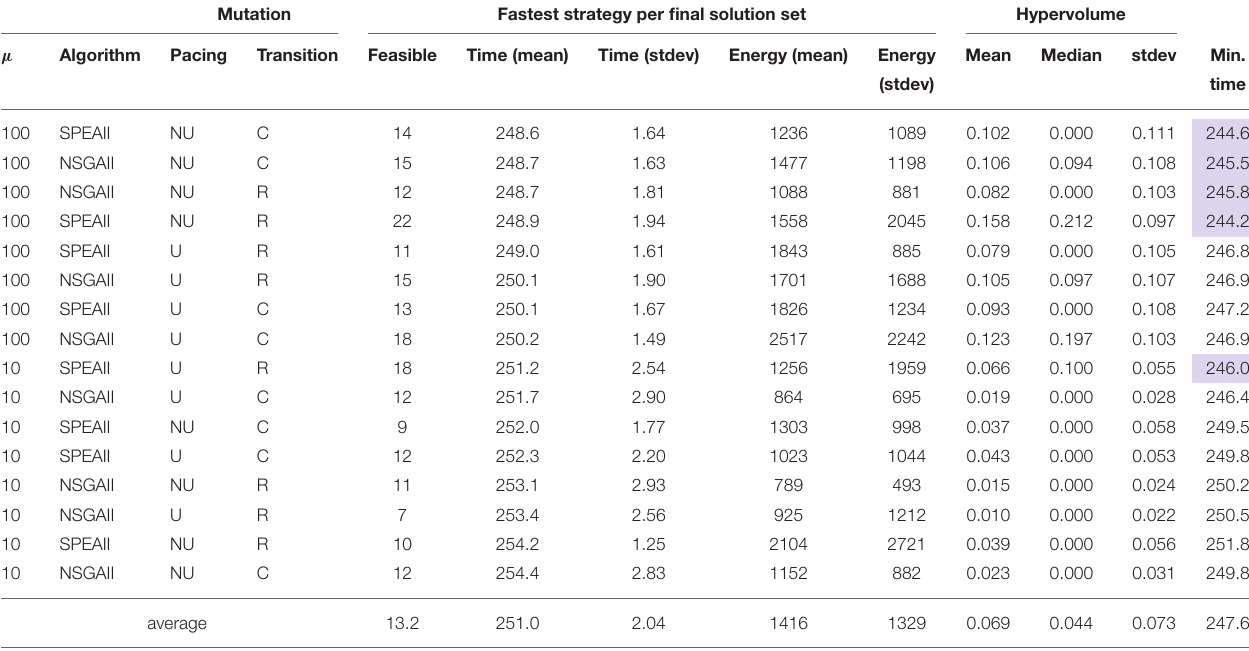
TABLE 2 | Results of the single-level multi-objective study. Mutation Fastest strategy per final solution set Hypervolume